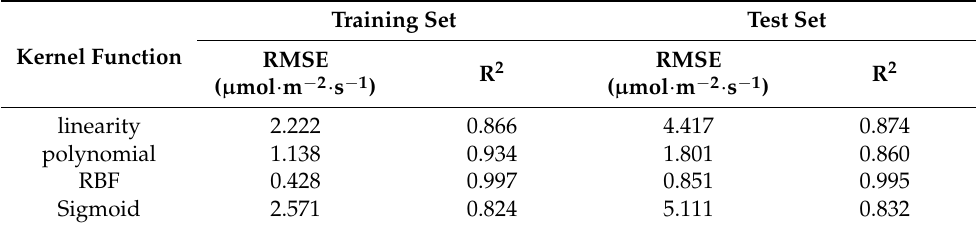
Table 3. Effect of four types of kernel function on model performance.